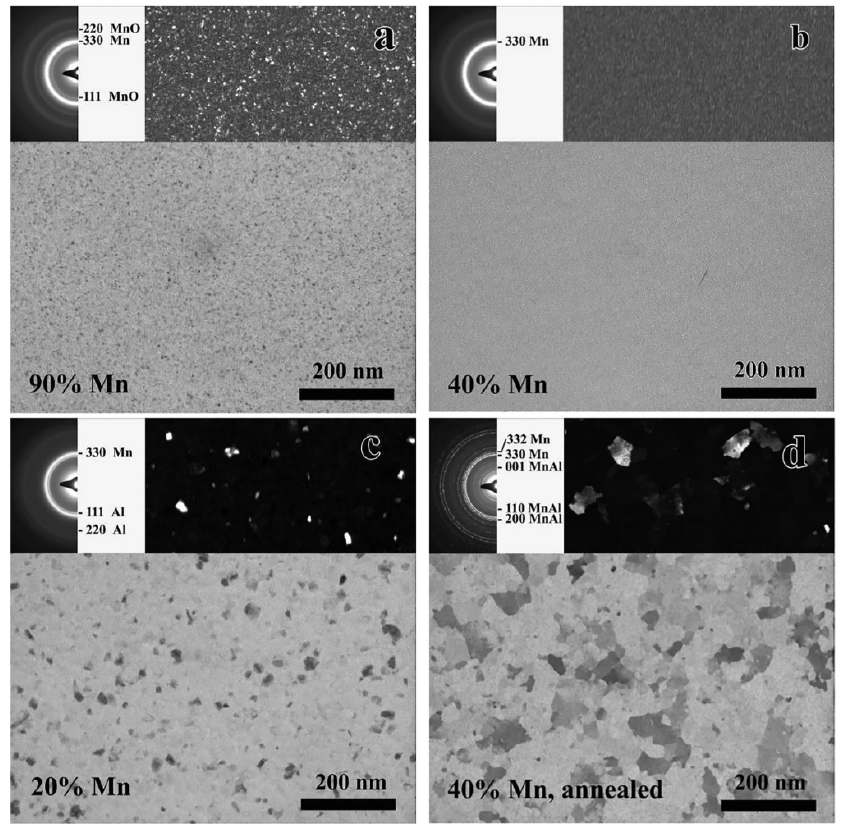
Figure 5. TEM micrographs of a Mn–Al μ‐ combinatorial sample at ( a ) 90%, ( b ) 40%, and ( c ) 20% Mn concentrations showing fine-grained cubic Mn with Mn oxide, amorphous MnAl, and amorphous MnAl with an fcc Al phase, respectively. The layer depicted in ( d ) is that of 40% Mn after heat treatment at 500 °C/0.5 h in Ar–H 2 mixture showing tetragonal MnAl phase. The insets are SAED patterns and DF images. Reproduced with permission from [22]. Copyright © 2018, Elsevier B.V.